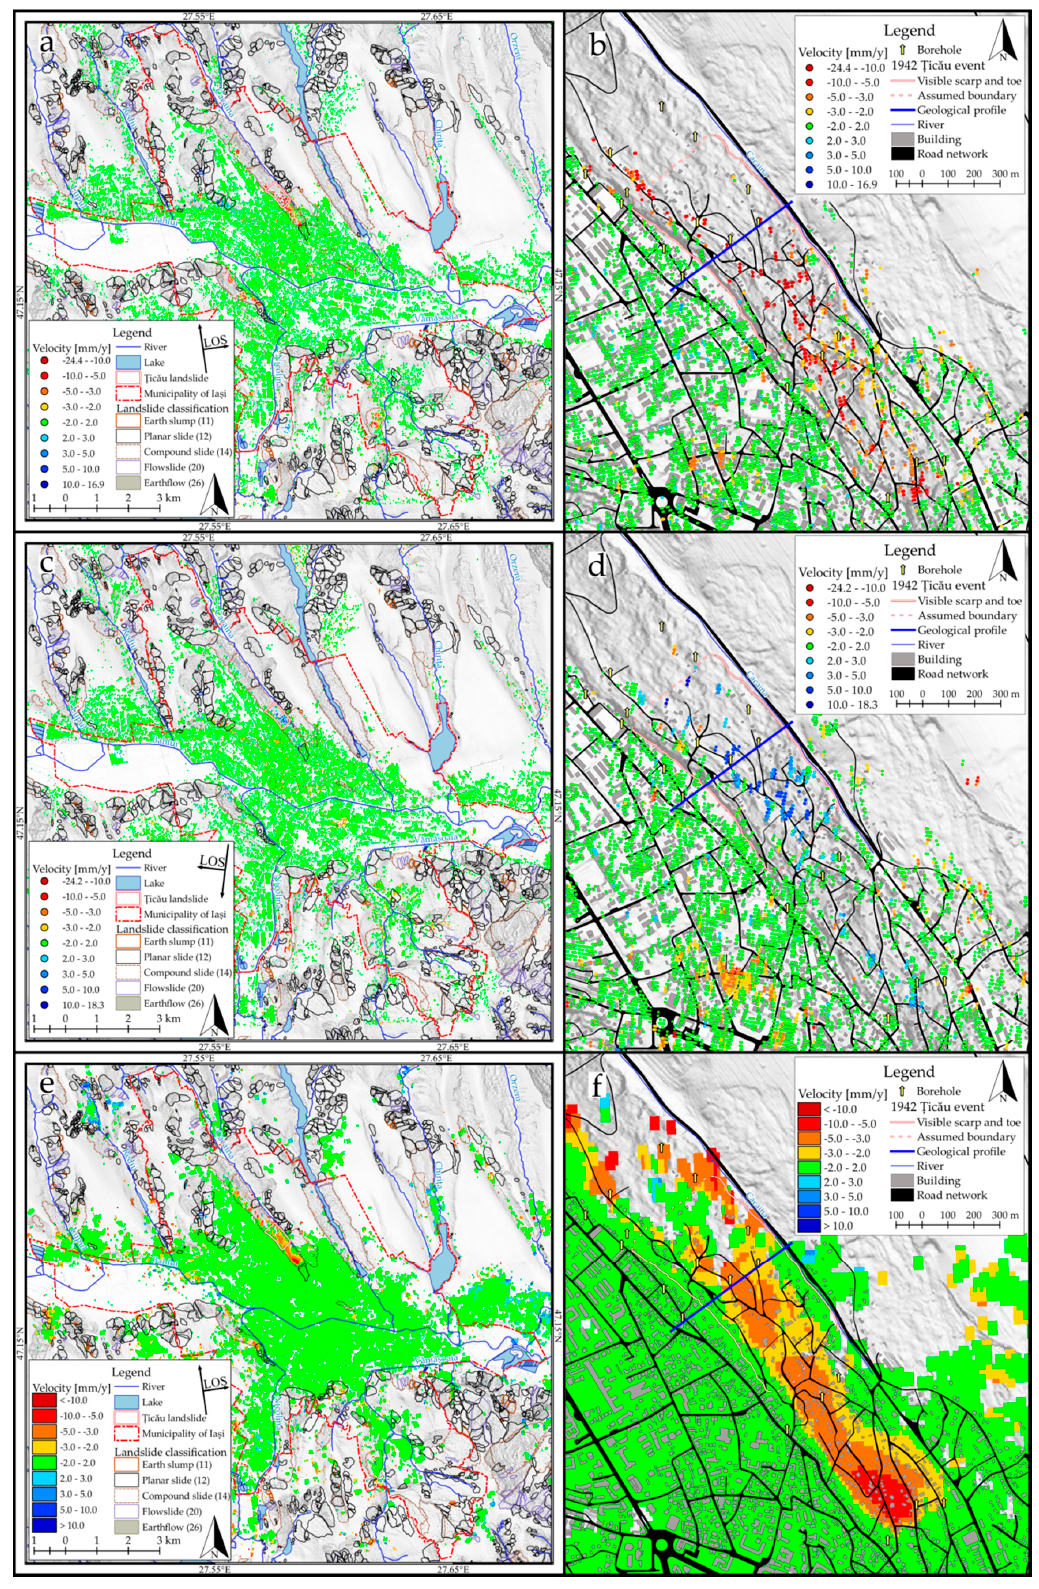
Figure 6. Velocity maps derived by processing the SAR data stacks: ( a , b ) Sentinel-1 ascending orbit, ( c , d ) Sentinel-1 descending orbit, and ( e , f ) ENVISAT ascending orbit. Images on the right are focused on the investigated T (high-resolution image available at